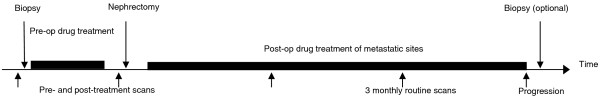
Overview of the PREDICT neo-adjuvant clinical trial strategy.